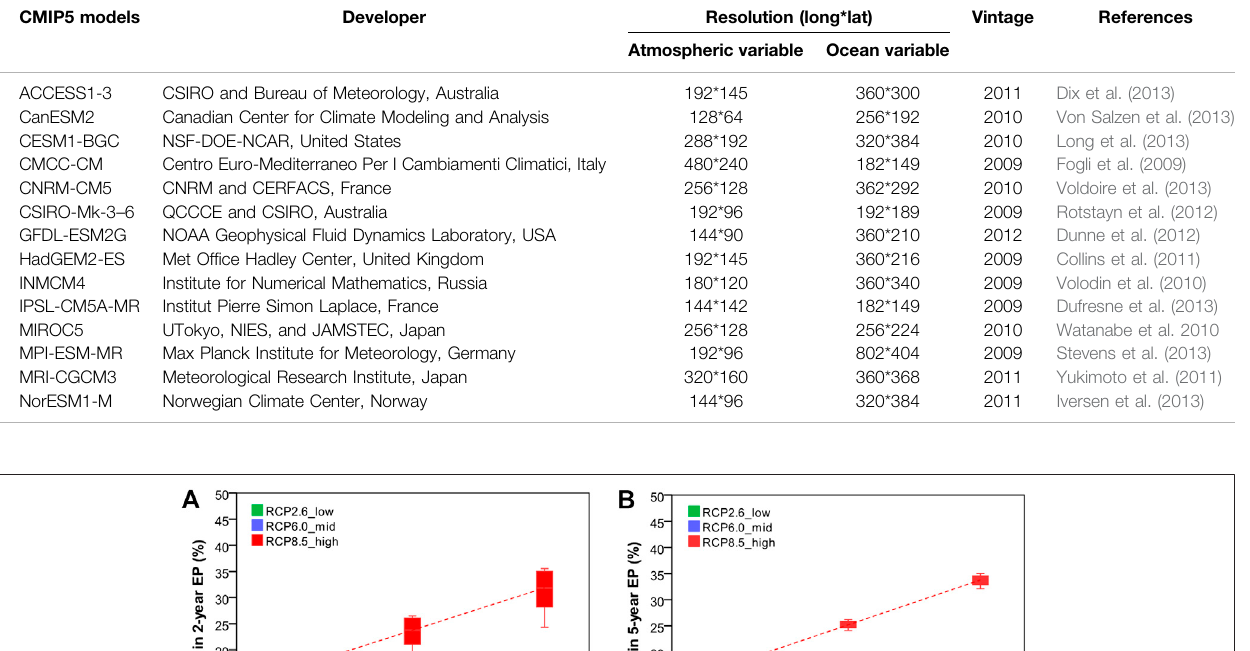
TABLE 2 | List of GCMs used in this study.